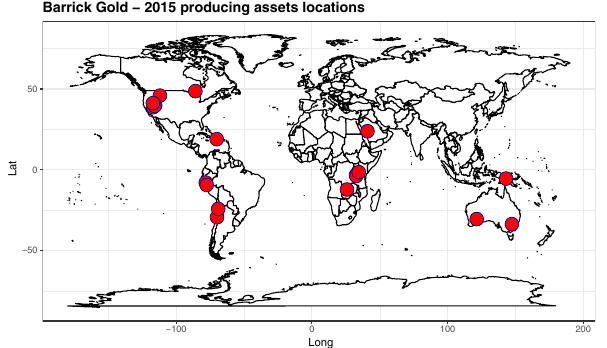
Figure A2. Map of Barrick Gold 2015 producing assets.